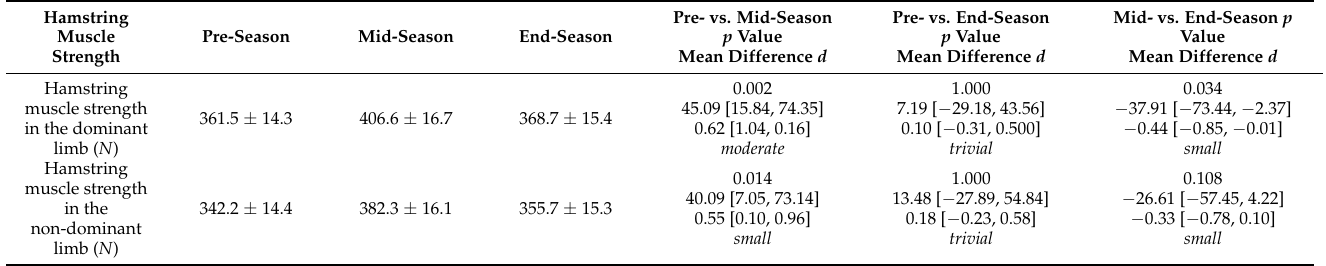
Table 1. Isometric hamstring muscle strength assessed at pre-season, mid-season, and end-season.